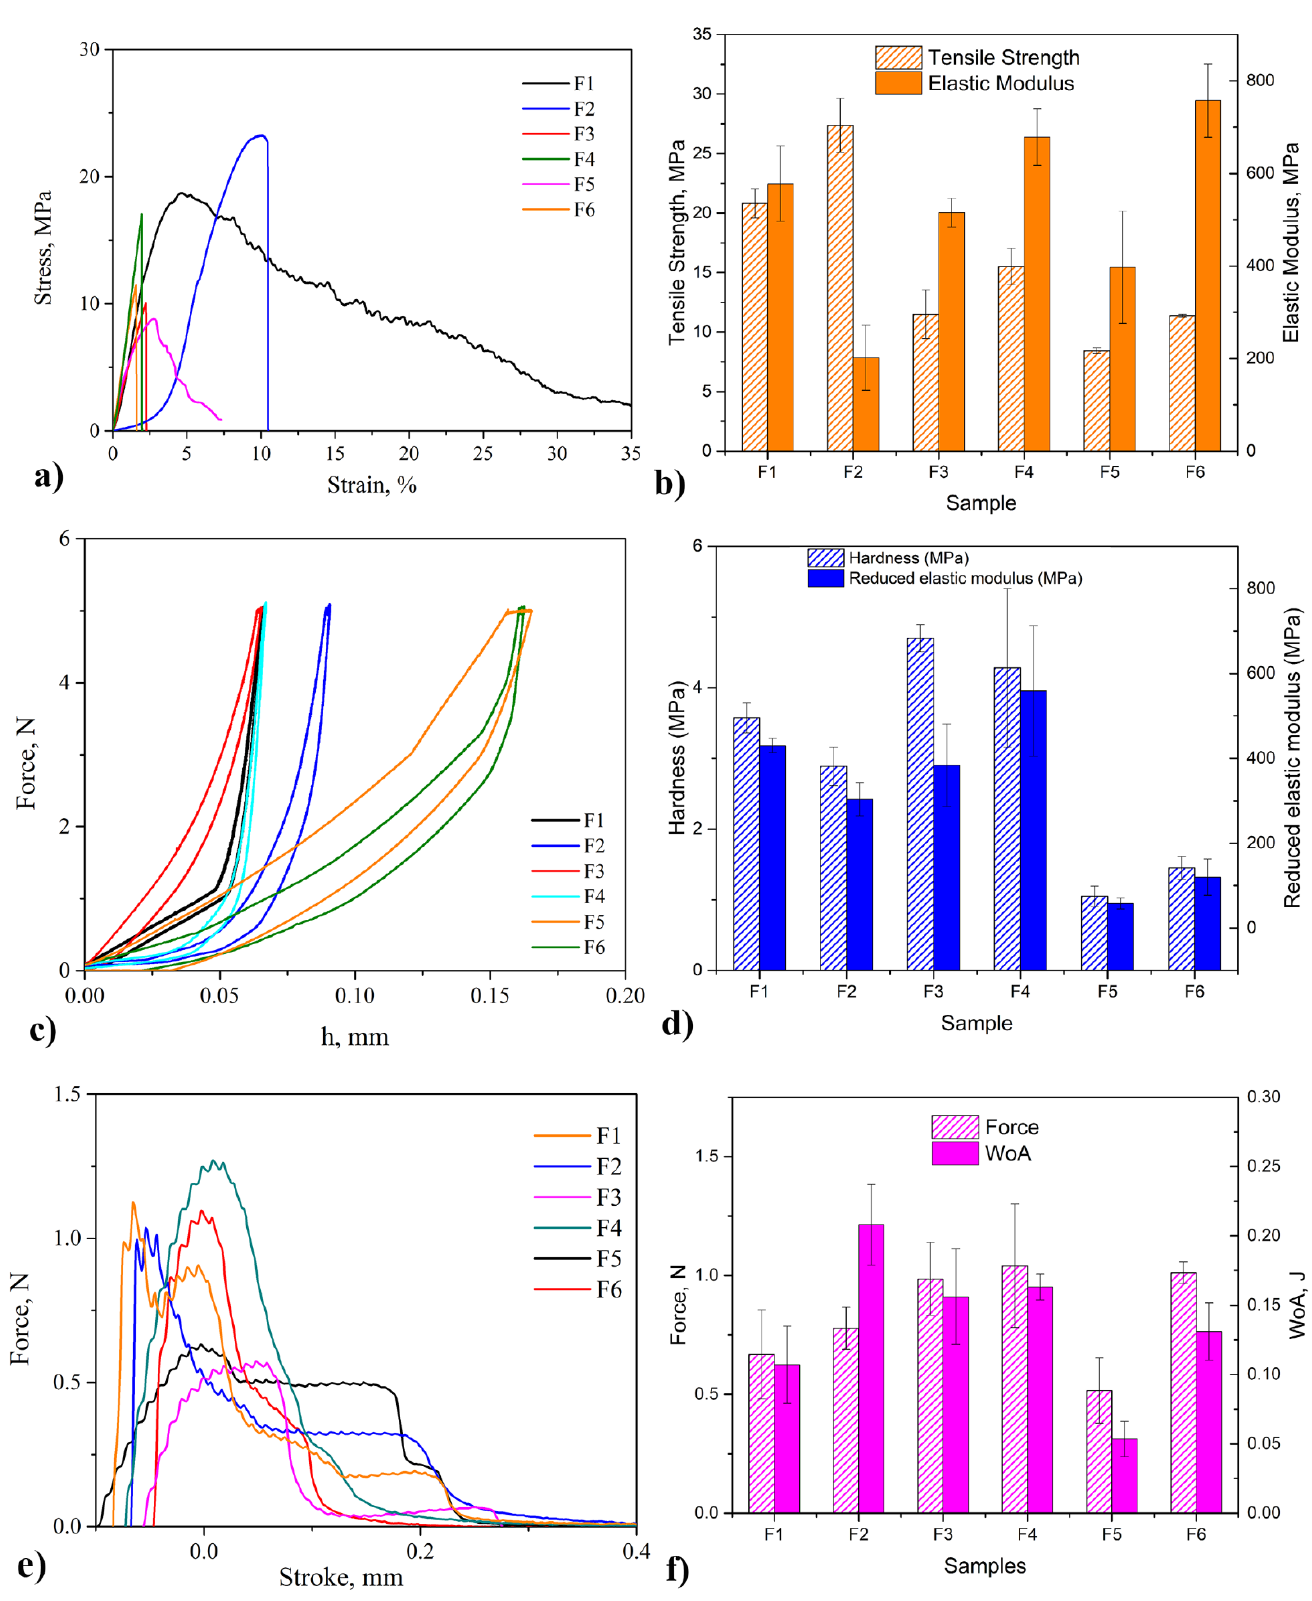
Figure 3. Results of: ( a , b ) tensile test; ( c , d ) microindentation; ( e , f ) mucoadhesion.